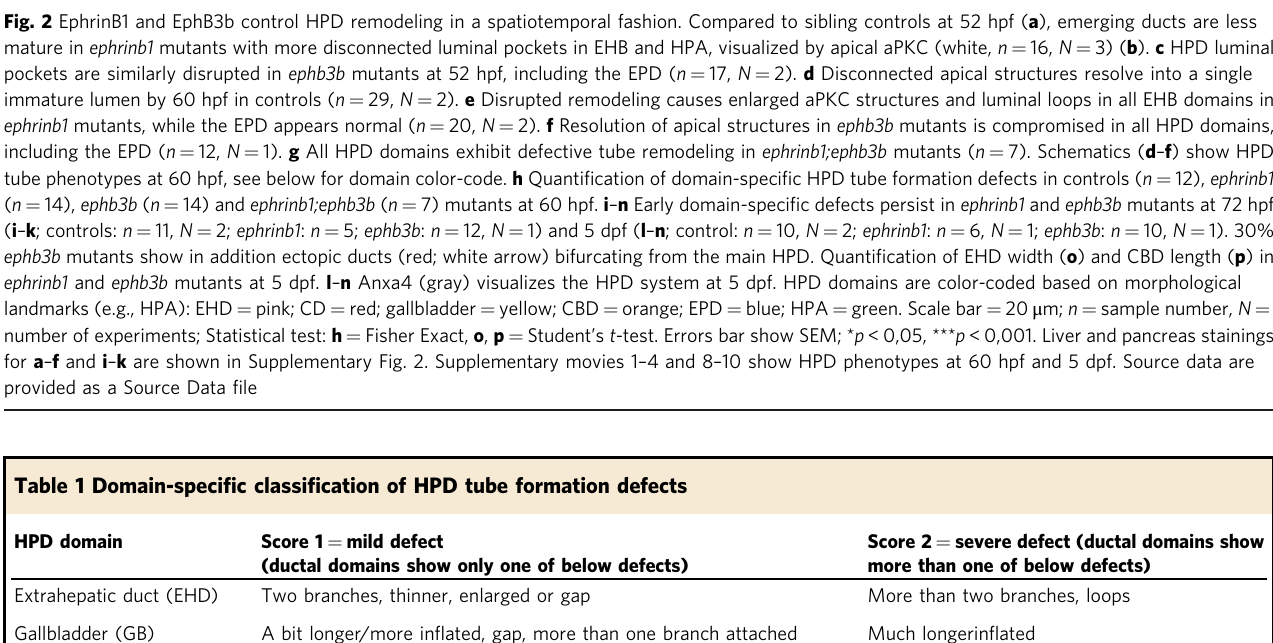
Fig. 2 EphrinB1 and EphB3b control HPD remodeling in a spatiotemporal fashion. Compared to sibling controls at 52 hpf ( a ), emerging ducts are less mature in ephrinb1 mutants with more disconnected luminal pockets in EHB and HPA, visualized by apical aPKC (white, n = 16, N = 3) ( b ). c HPD luminal pockets are similarly disrupted in ephb3b mutants at 52 hpf, including the EPD ( n = 17, N = 2). d Disconnected apical structures resolve into a single immature lumen by 60 hpf in controls ( n = 29, N = 2). e Disrupted remodeling causes enlarged aPKC structures and luminal loops in all EHB domains in ephrinb1 mutants, while the EPD appears normal ( n = 20, N = 2). f Resolution of apical structures in ephb3b mutants is compromised in all HPD domains, including the EPD ( n = 12, N = 1). g All HPD domains exhibit defective tube remodeling in ephrinb1;ephb3b mutants ( n = 7). Schematics ( d – f ) show HPD tube phenotypes at 60 hpf, see below for domain color-code. h Quanti fi cation of domain-speci fi c HPD tube formation defects in controls ( n = 12), ephrinb1